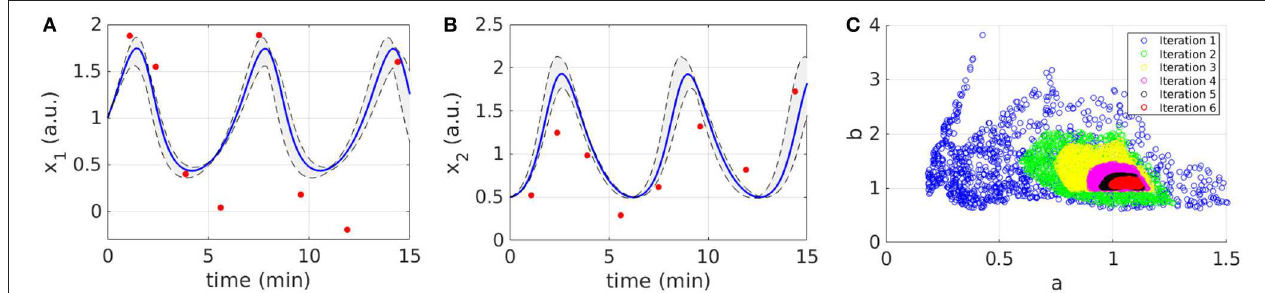
FIGURE 2 | Results of CRC for model M1. (A,B) The red line is the time behavior of output variables when the parameter vector is equal to p 6 m (see Table 3 ); red dots are the experimental data; the gray area represents the uncertainty in the temporal behavior of observables when parameters vary between the 2.5th and 97.5th percentile of their corresponding conditional pdfs. (C) Scatter plot of the sample distribution of f a | P